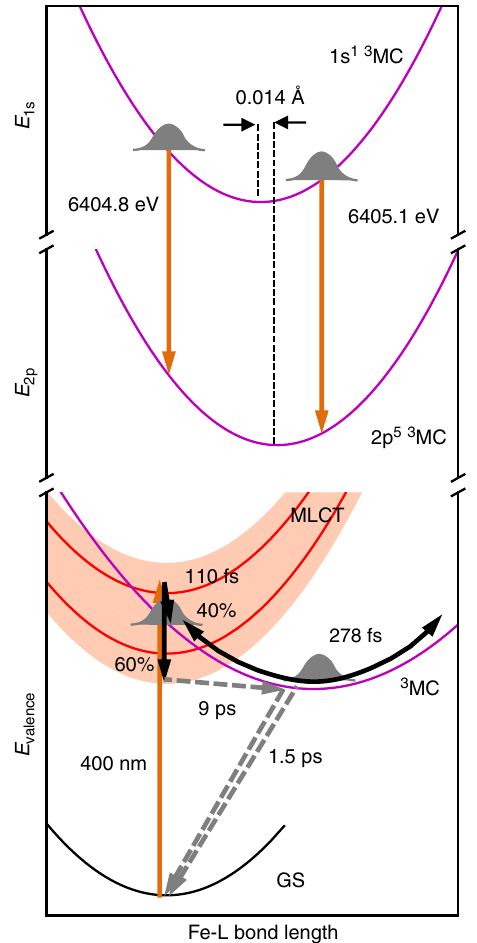
Fig. 7 Excited state dynamics of [Fe(bmip) 2 ] 2 + . (Lower half) Population and structural dynamics following photoexcitation. Initial MLCT state relaxes ultrafast with 110 fs time constant and 40% yield to the 3 MC state which triggers vibrational wavepacket dynamics along an effective Fe-ligand (L) stretching coordinate with 278 fs period. The remaining 60% of the MLCT decays to the GS through the 3 MC with a 9 ps time constant. Black line: GS potential energy surface (PES); red lines and red shaded area: MLCT states PESs; magenta line: 3 MC state PES. Orange arrows: radiative transitions; black arrows: fast coherent dynamics; Gray dashed arrows: slower incoherent dynamics. (Upper half) The origin of XES structural sensitivity due to core-level vibronic coupling between 1s and 2p core- ionized states. Note the displacement of the respective 3 MC 1s and 2p core-ionized PESs (magenta lines). All PESs are